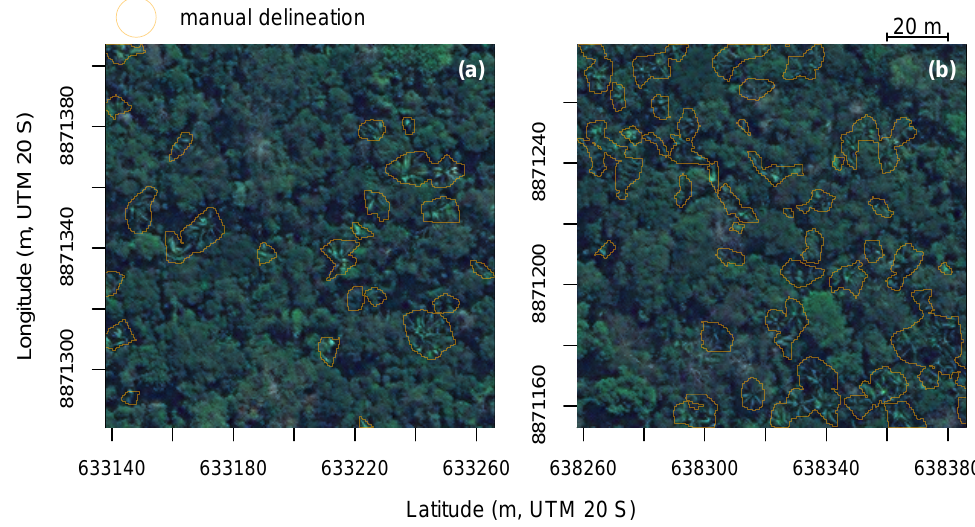
Figure 3. Example of subsets of the GeoEye-1 image (a and b) and the corresponding manual delineated segments of canopy palms. Satellite image courtesy of the DigitalGlobe